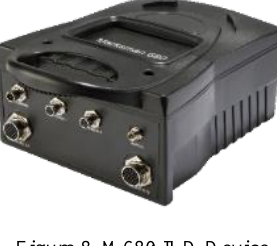
Figure 8. M680 ILD Device